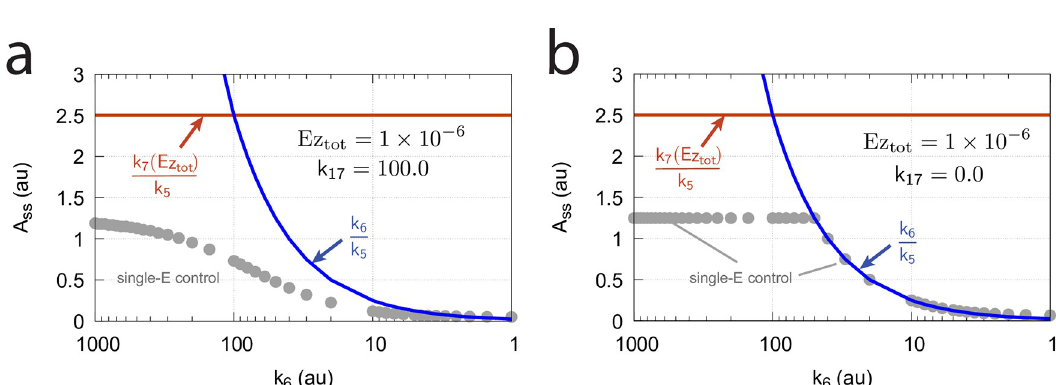
Fig 45. A (= A ) as a function of k 6 when (a) k 17 =100.0 and (b) k 17 =0.0. Gray solid points show the numerically calculated values ss set of A ss , while red and blue curves show the values of k 7 ( Ez tot )/ k 5 and k 6 / k 5 , respectively. Other rate constant values: k 1 =800.0, k 2 =1.0, k 3 =0.0, k 4 =1.0, k 5 =40.0, k 7 =1 × 10 8 , k 9 = k 11 = k 13 =1 × 10 8 , and k 10 = k 12 = k 14 =1 × 10 3 . Initial concentrations: A 0 =1.0, E 1,0 =9.9 × 10 1 , E 2,0 =5.04 × 10 − 1 , Ez 0 =6.03 × 10 − 9 , (E 1 � Ez) 0 =4.97 × 10 − 7 , (Ez � � E 2 ) 0 =1.0 × 10 − 7 , and Ez � step-length: 0.01 time units.